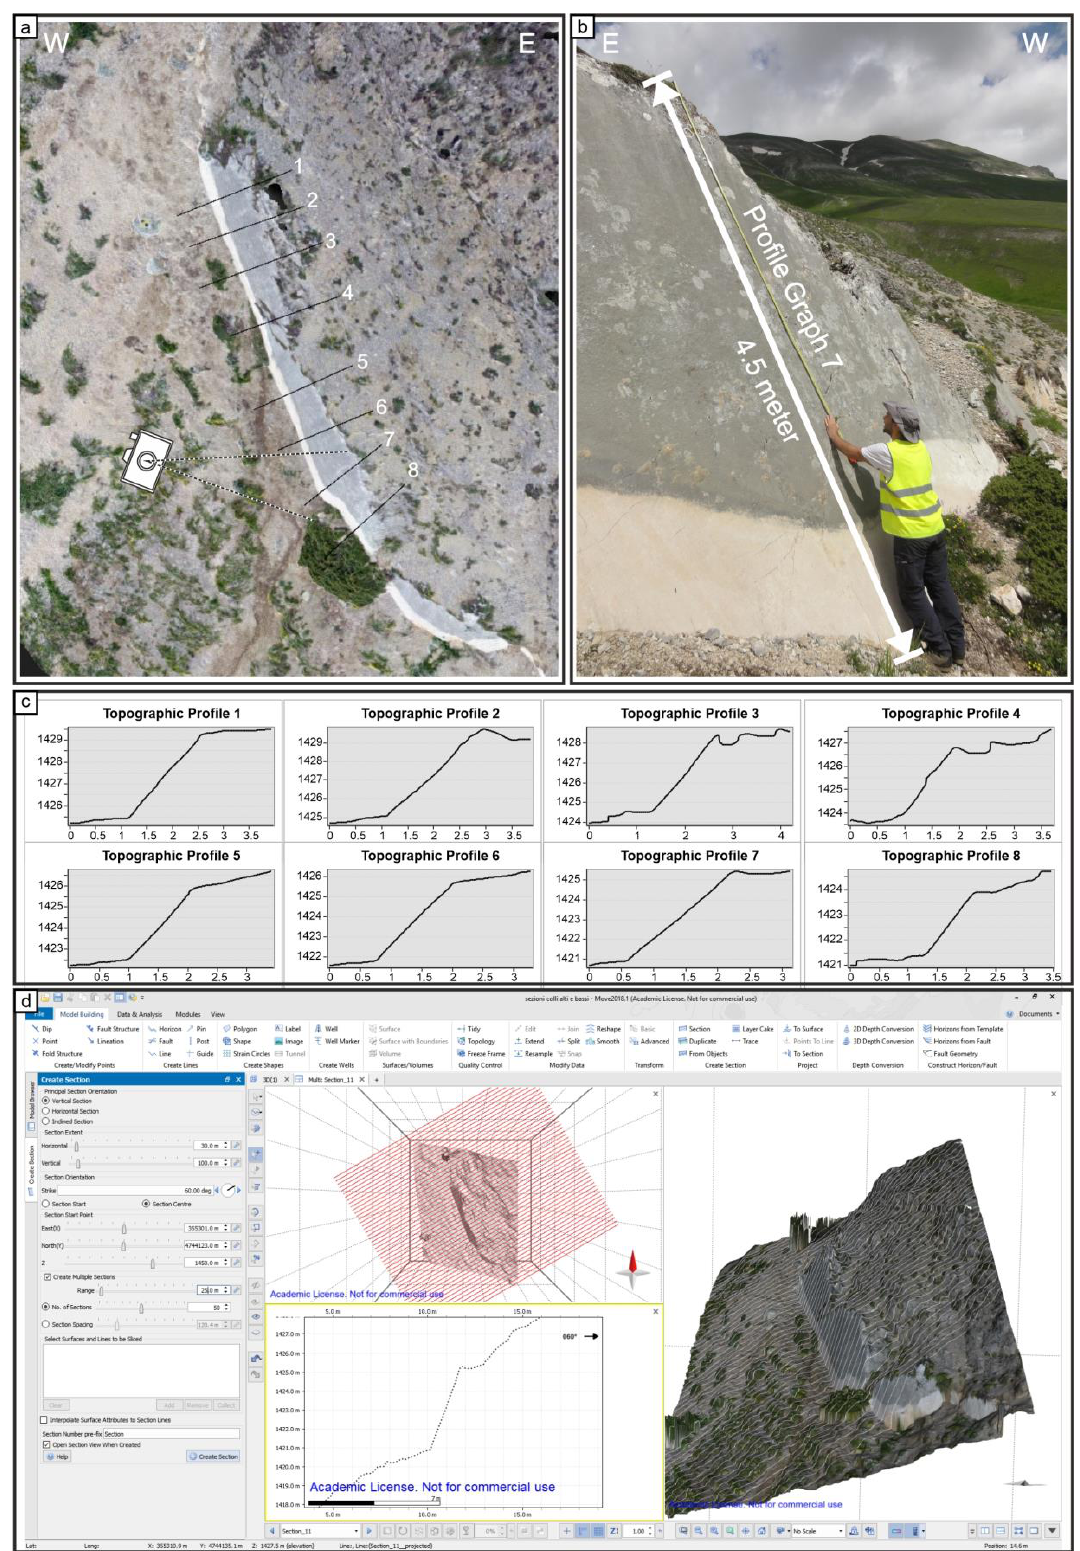
Figure 7. Georeferenced orthomosaic of CAB. ( a ) Digital Surface Model (DSM) of CAB and trace of topographic profile (from 1 to 8); ( b ) manual measuring of the scarp height associated to the CAB; ( c ) topographic profiles obtained using 3D Analyst extension of ESRI ArcGis; ( d ) topographic profiles obtained through move software.